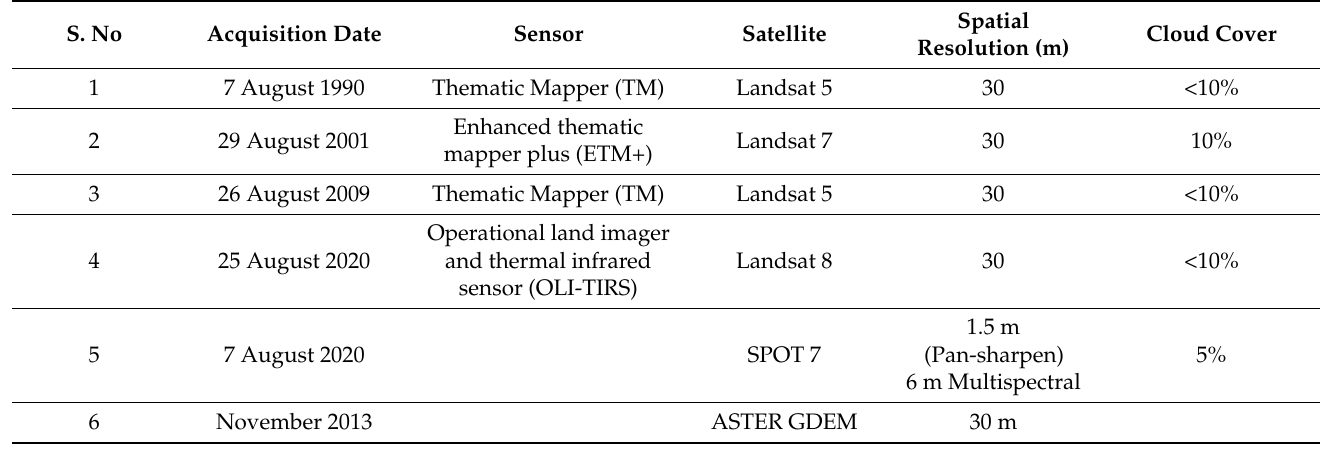
Table 1. Remote sensing data was used for glacier mapping in this study.